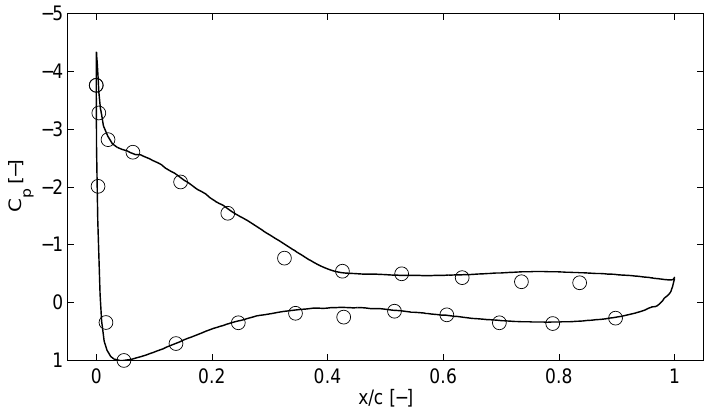
Figure 5. C distribution from r = 0 : 60 R for U 1 = 24 m/s, corresponding to AoA = 17 (cid:14) . p The circles indicate 3D experimental results, and the full line shows 3D numerical